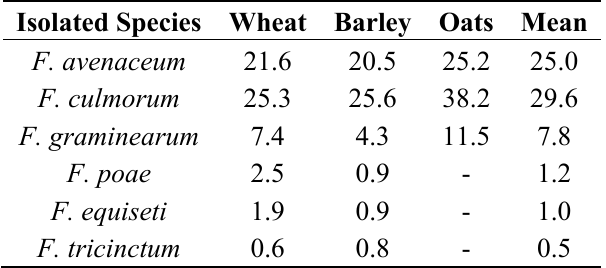
Table 1. Occurrence (%) of Fusarium spp. isolated from symptomatic cereal plants in Norway from 1980 to 1983, as determined by Haave [3].